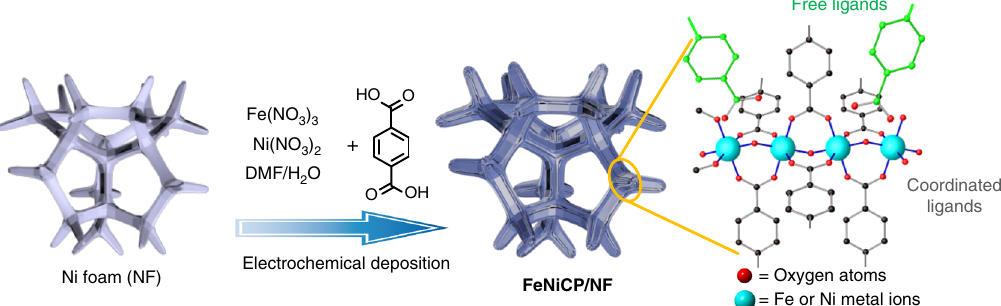
Fig. 1 Schematic illustration of the fabrication procedure of the Ni-Fe coordination polymer prepared via an in situ electrochemical deposition method on Ni foam (NF) as a working electrode ( NiFeCP/NF